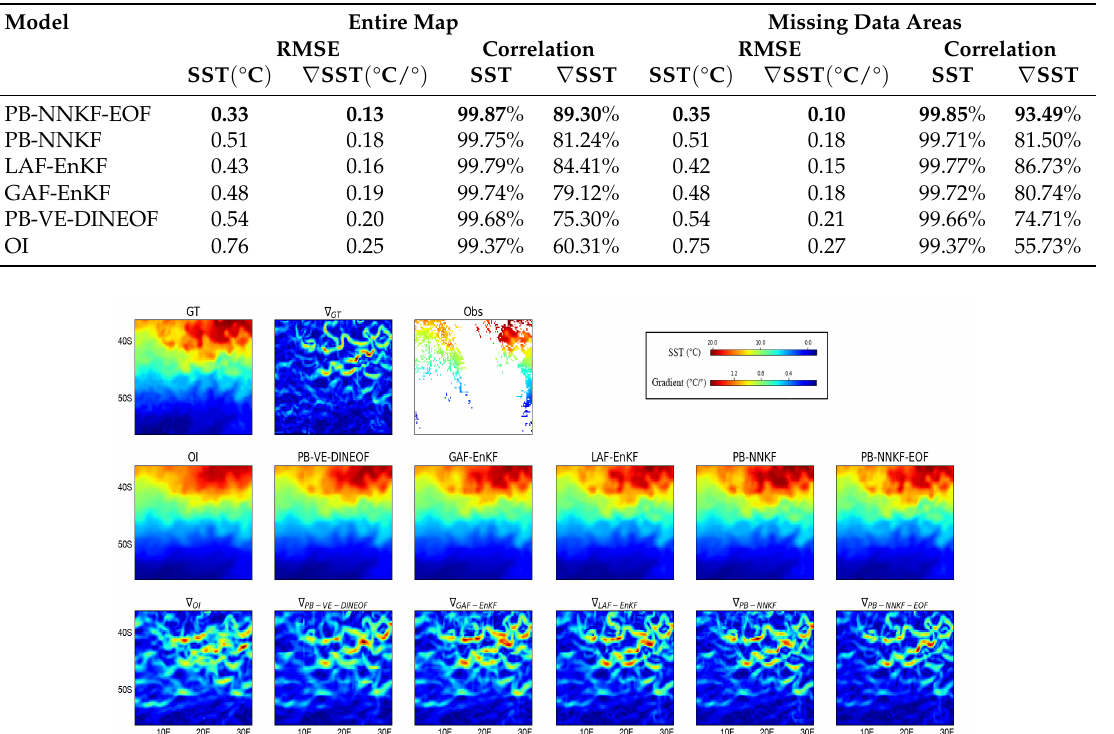
Figure 4. Interpolation of the SST field on 19 July 2015: first row, the reference SST, its gradient and the observation with missing data (here, 82% of missing data); second row, interpolation results using respectively OI, PB-VE-DINEOF, GAF-EnKF, LAF-EnKF, PB-NN-NNKF, PB-NN-NNKF-EOF; third row, gradient of the reconstructed